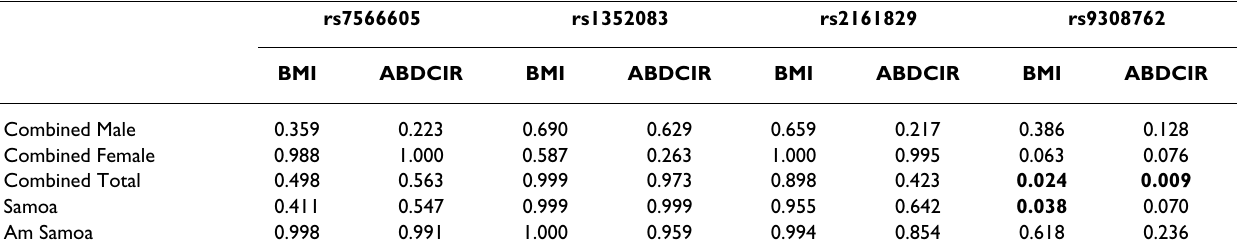
Table 2: Association (empirical p-values) of INSIG2 tagSNPs with BMI and ABDCIR based on additive model (adjusted for age in all samples, for location in the combined samples and for sex in the Samoa and American Samoa